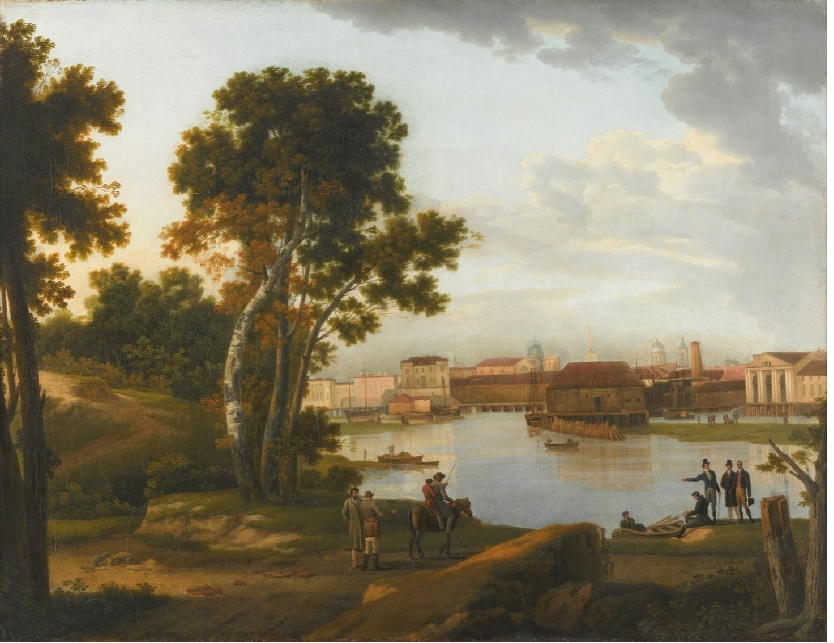
Figure 11. Sylvester Shchedrin. View of the Tuchkov Bridge and Vasilievsky Island from Petrovsky Island in Saint Petersburg , 1815. State Tretyakov Gallery, Moscow.